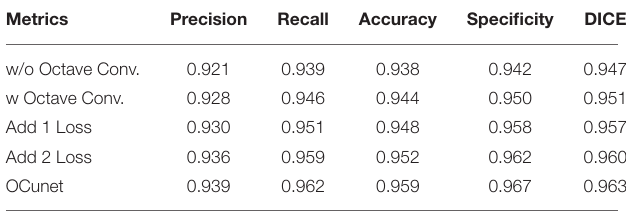
TABLE 2 | Ablation study